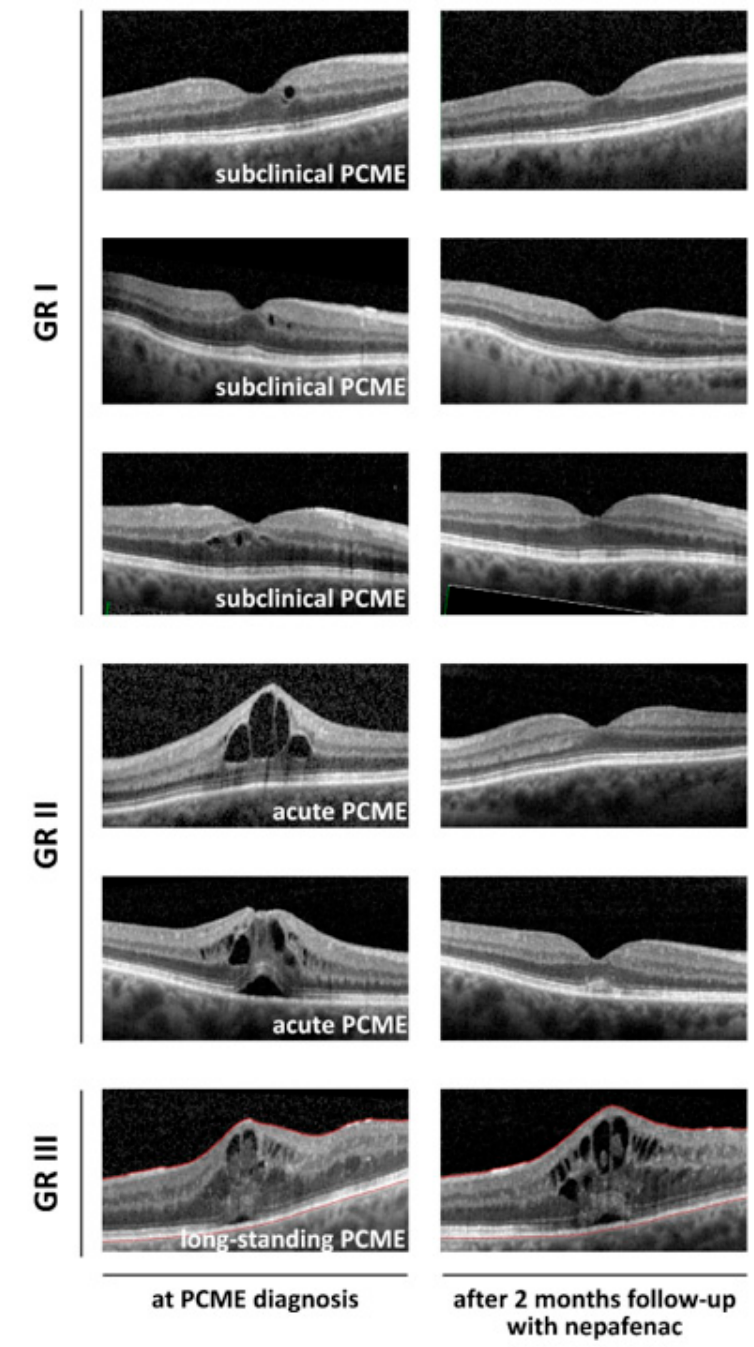
Figure 1. Representative OCT scans.